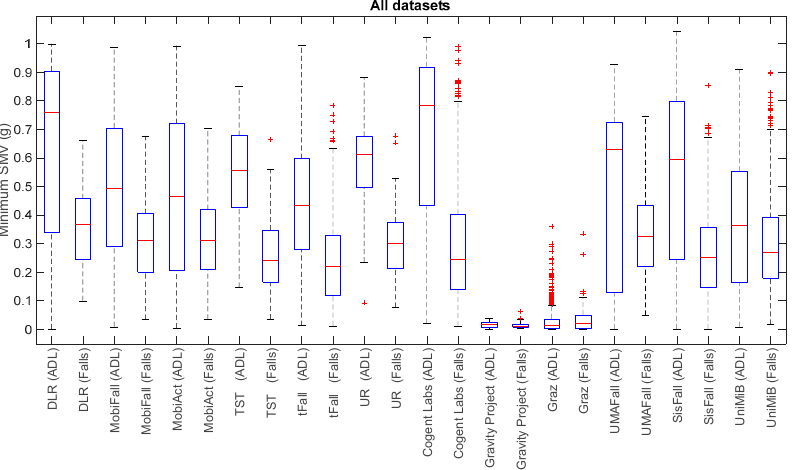
Figure 2. Boxplots of the of the minimum acceleration module for the falls and ADLs of all the datasets (for all the datasets only the acceleration signal at the waist or—if not available—at the thigh is considered).